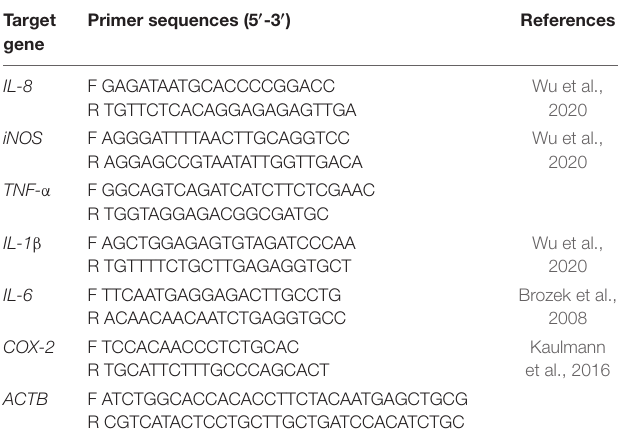
TABLE 1 | Primer sequences used in